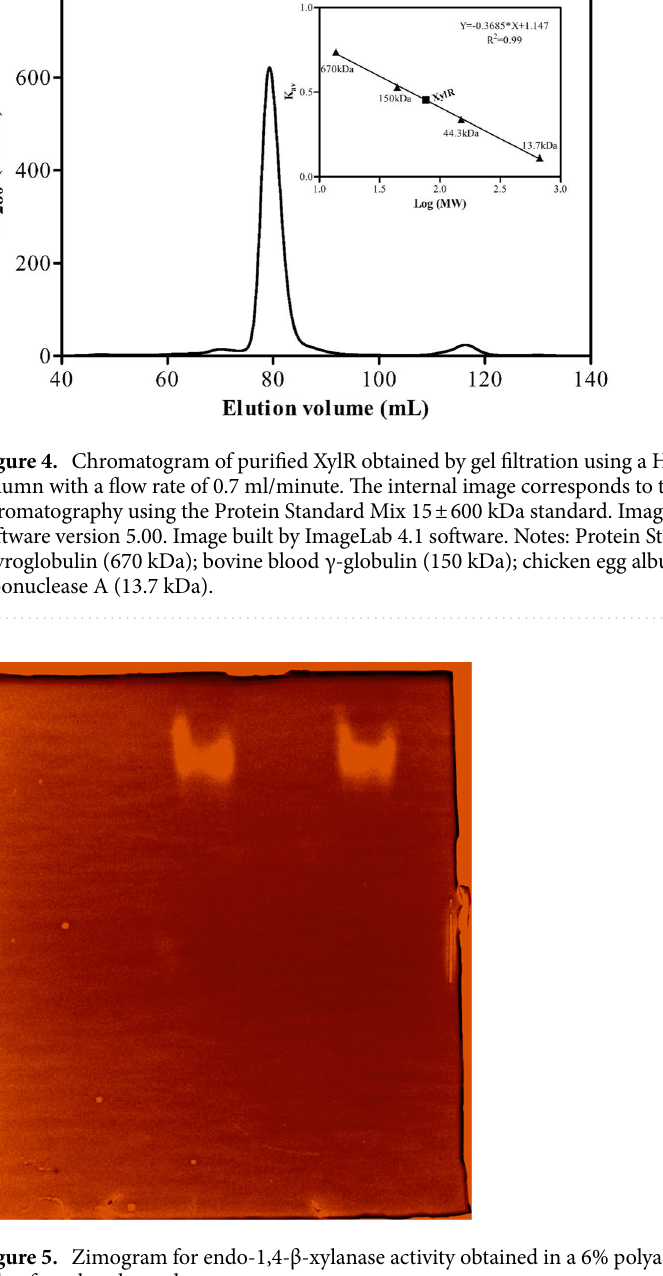
Figure 5. Zimogram for endo-1,4-β-xylanase activity obtained in a 6% polyacrylamide gel copolymerized with xylan from